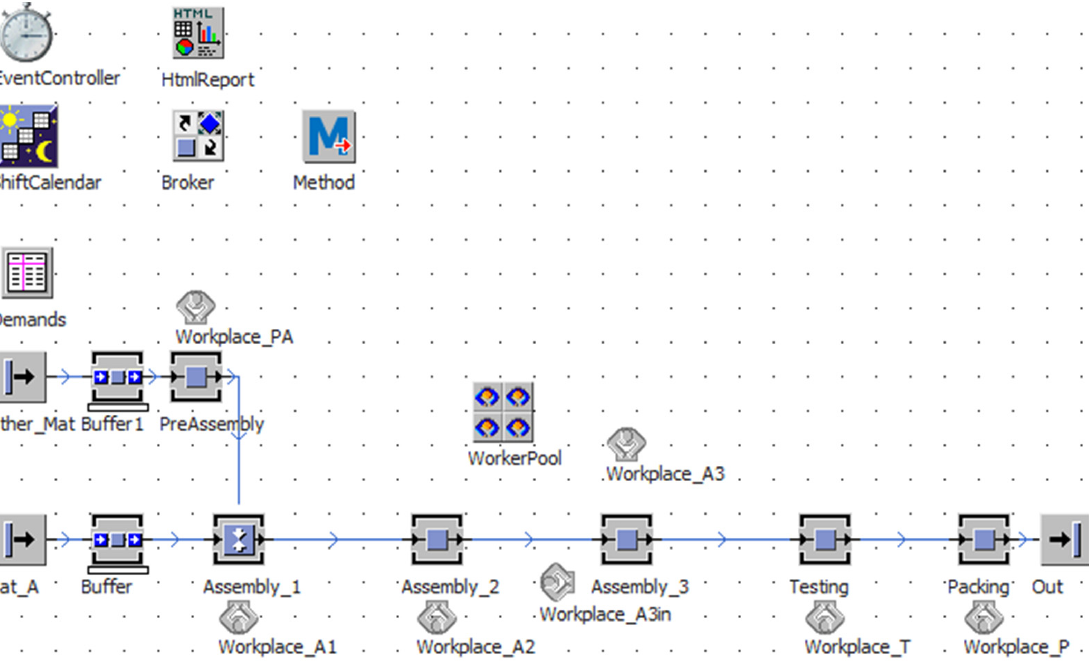
Figure 7. Simulation model of the assembly line—original state.